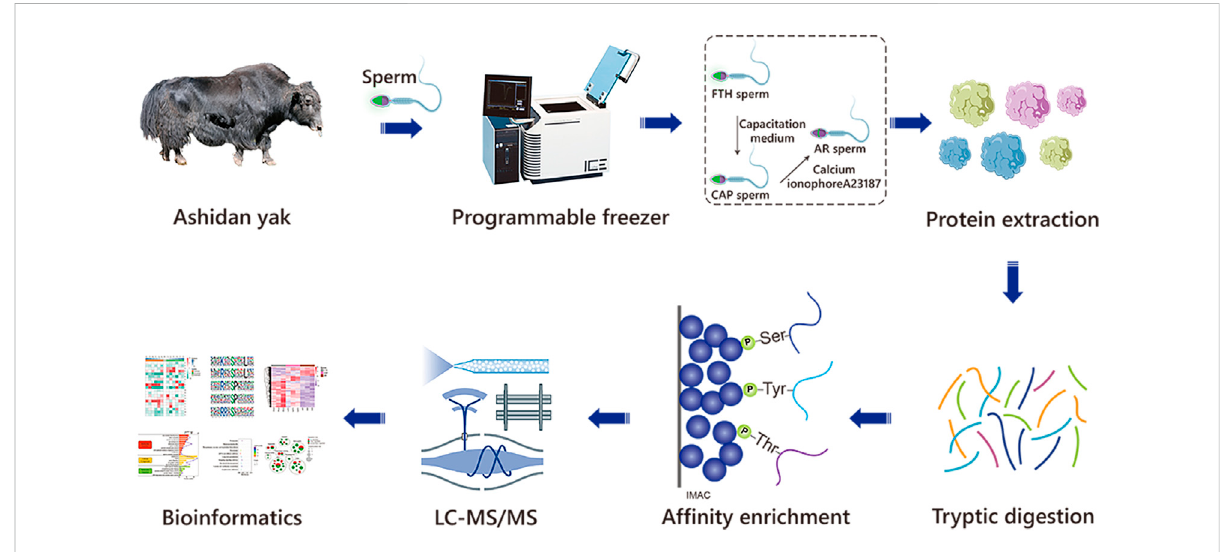
The work fl ow of the experimental procedures. The identi fi cation of phosphoproteomics in yak sperm was performed by TMT labeling combined with LC-MS/MS after capacitation and AR in vitro